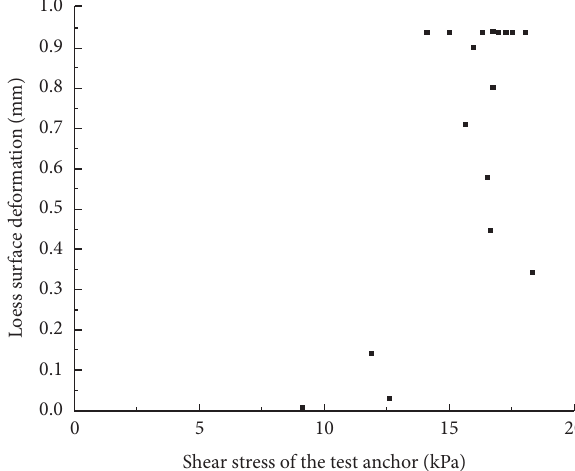
Figure 9: Changing trend between loess surface deformation and shear stress of the test anchor (the